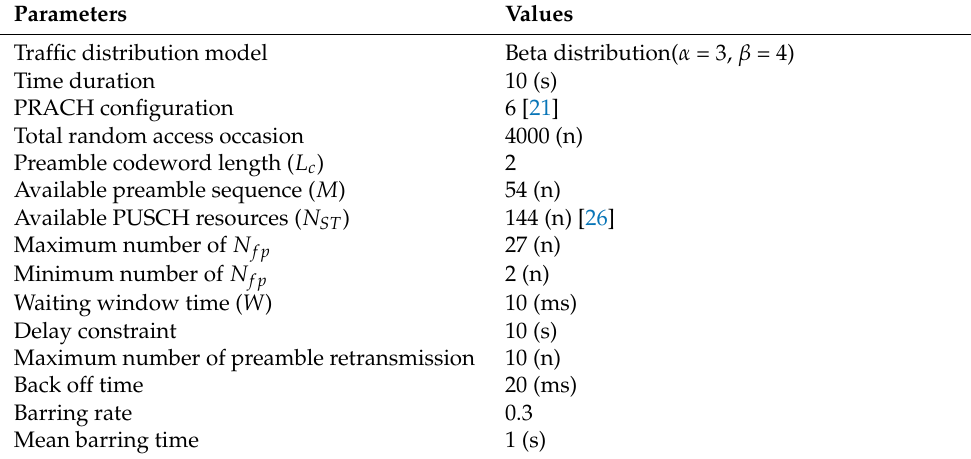
Table 1. Simulation